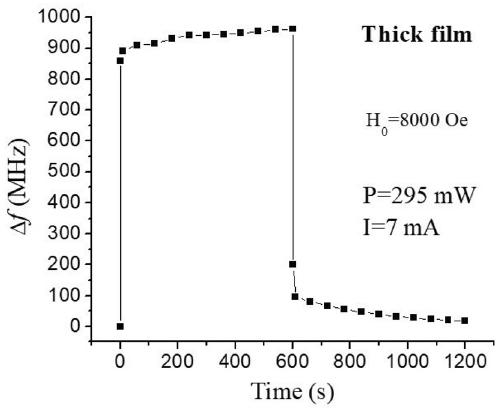
Figure 5. FMR frequency shift as a function of time when a DC current was passed through the thick film of BaM. The frequency shift was measured when the current was on for 10 min and then when it was turned